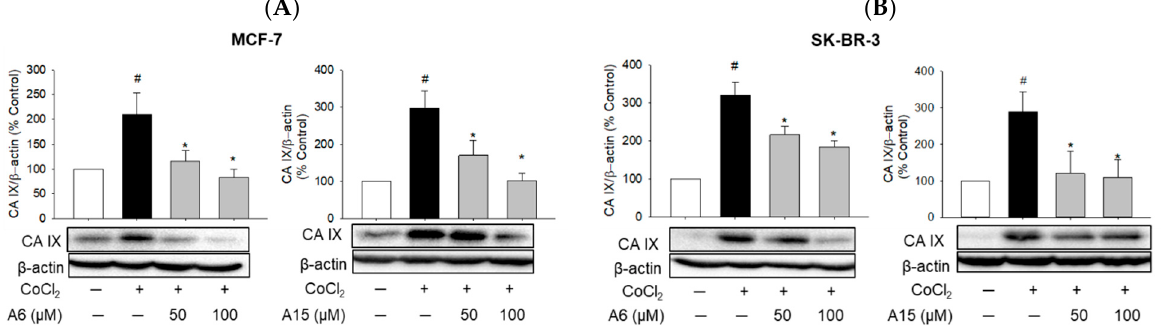
Figure 5. Suppression of CoCl 2 -induced CA IX expression by A6 and A15 in MCF-7 and SK-BR-3 cells. ( A ) MCF-7 and ( B ) SK-BR-3 cells were treated with A6 or A15 (50 and 100 μ M) in the presence or absence of CoCl 2 (100 μ M) for 48 h. Control cells were treated with the media containing 0.1% DMSO instead. Protein levels of CA IX were determined by western blotting analyses using anti-CA IX antibody. β -Actin was used for normalization. The expression level of CA IX is expressed as a percentage of the control measured in the vehicle-treated control cells. Representative blots are shown. Data are displayed as mean ± SEM from three independent experiments. # p < 0.05 and * p < 0.05 vs. the vehicle-treated control cells and CoCl 2 -treated cells, respectively.